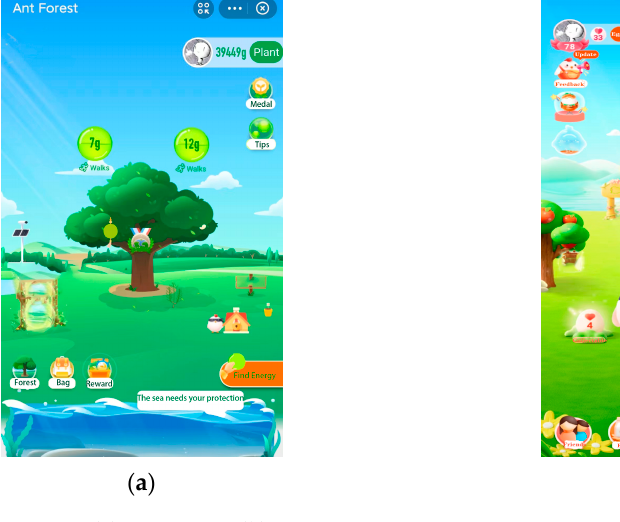
Figure 2. ( a ) Ant Forest; ( b ) Ant Manor.